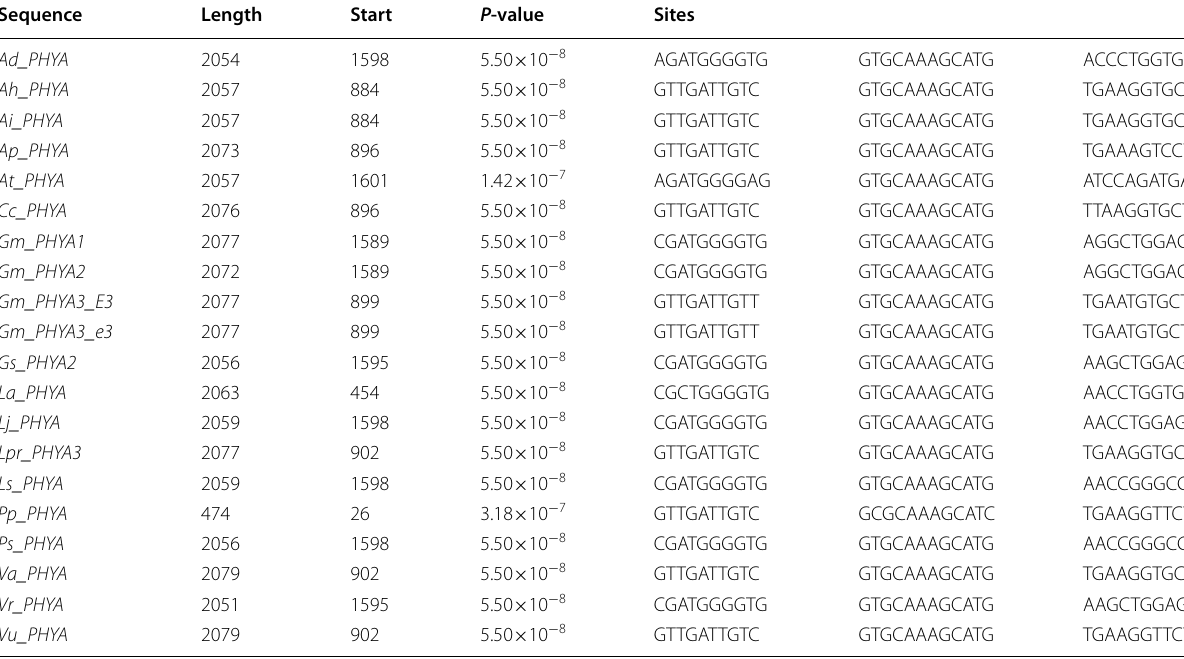
The column representing sequences are phytochrome A ( PHY A ) nucleotide sequences from 20 species. Ad_PHYA Arachis durianesis , Ah_PHYA Arachis hypogea , Ai_PHYA Arachis ipaniensis , Ap_PHYA Abrus precatorious , At_PHYA Arabidopsis thaliana , Cc_PHYA Cajanus cajan , Gm_PHYA1 , Gm_PHYA2 , Gm_PHYA3_E3 , Gm_PHYA3_e3 Glycine max PHY A homologs, Gs_PHYA2 Glycine soja , La_PHYA Lupinus angustifolius , Lj_PHYA Lotus japonicus , Lpr_PHYA3 Lablab purpureus , Ls_PHYA Lathyrus sativus , Pp_ PHYA Pongamia pinnata , Ps_PHYA Pisum sativum , Va_PHYA Vigna angularis , Vr_PHYA Vigna radiata , Vu_PHYA Vigna unguiculata . The following columns present length of DNA sequence, start position, random letters probability and the sequence of the conserved motif